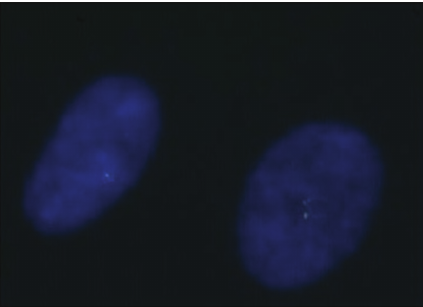
Figure 4: Cytogenetic analysis of the tumor’s cells, demonstrating the presence of XY